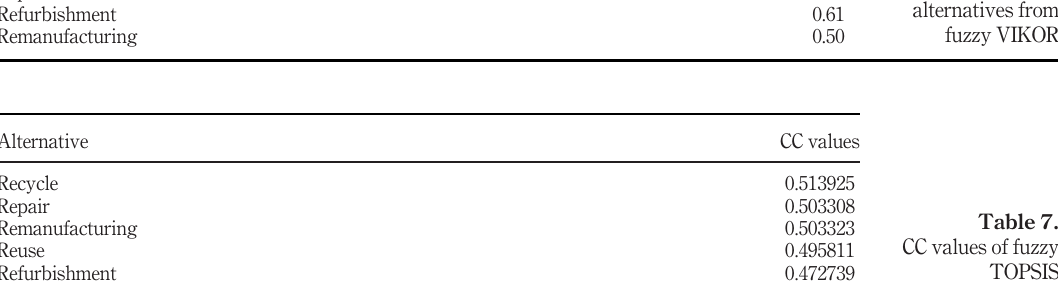
Table 6. Q value of